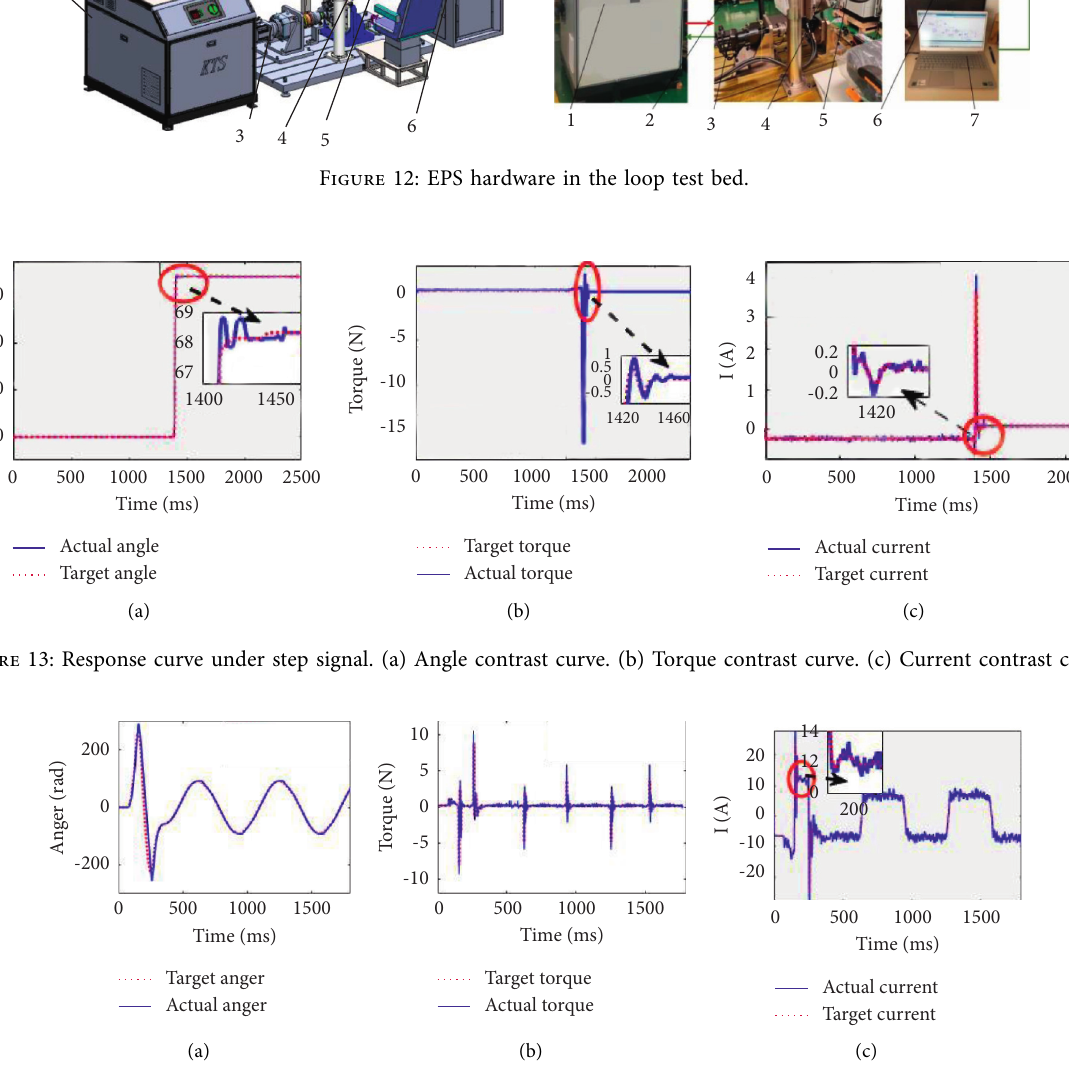
Figure 14: Response curve under sinusoidal signal. (a) Angle contrast curve. (b) Torque contrast curve. (c) Current contrast curve.